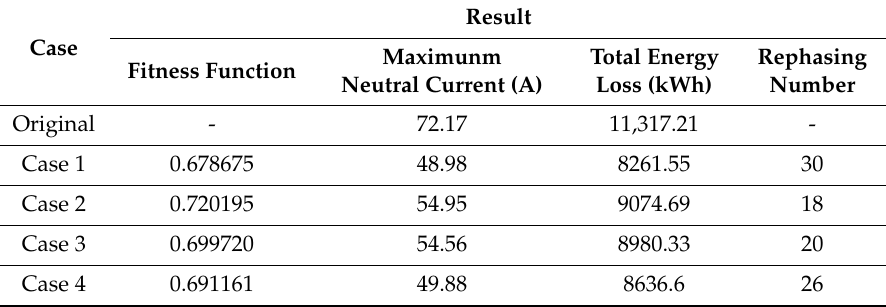
Figure 20. The iterative convergence diagram of Case 4: ( a ) fitness function and rephasing number and ( b ) neutral current and total energy loss. Table 2. Performance comparison of four cases with the original